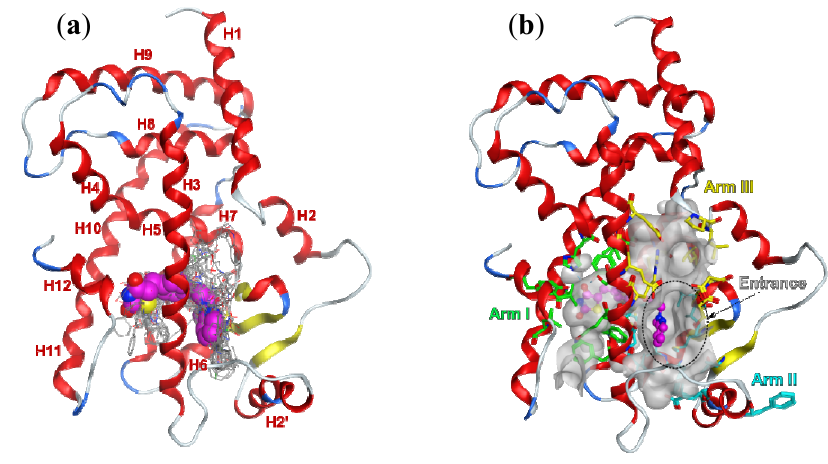
values in Table S1); in red are 50